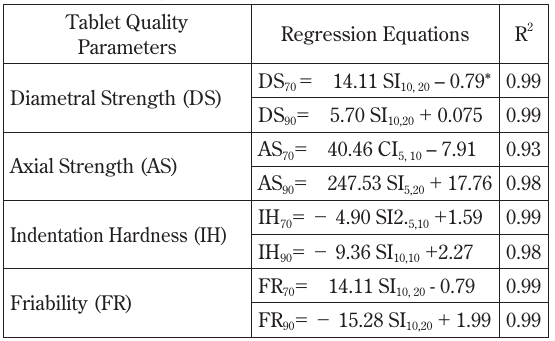
Table 7 Regression equations for predicting the tablet quality